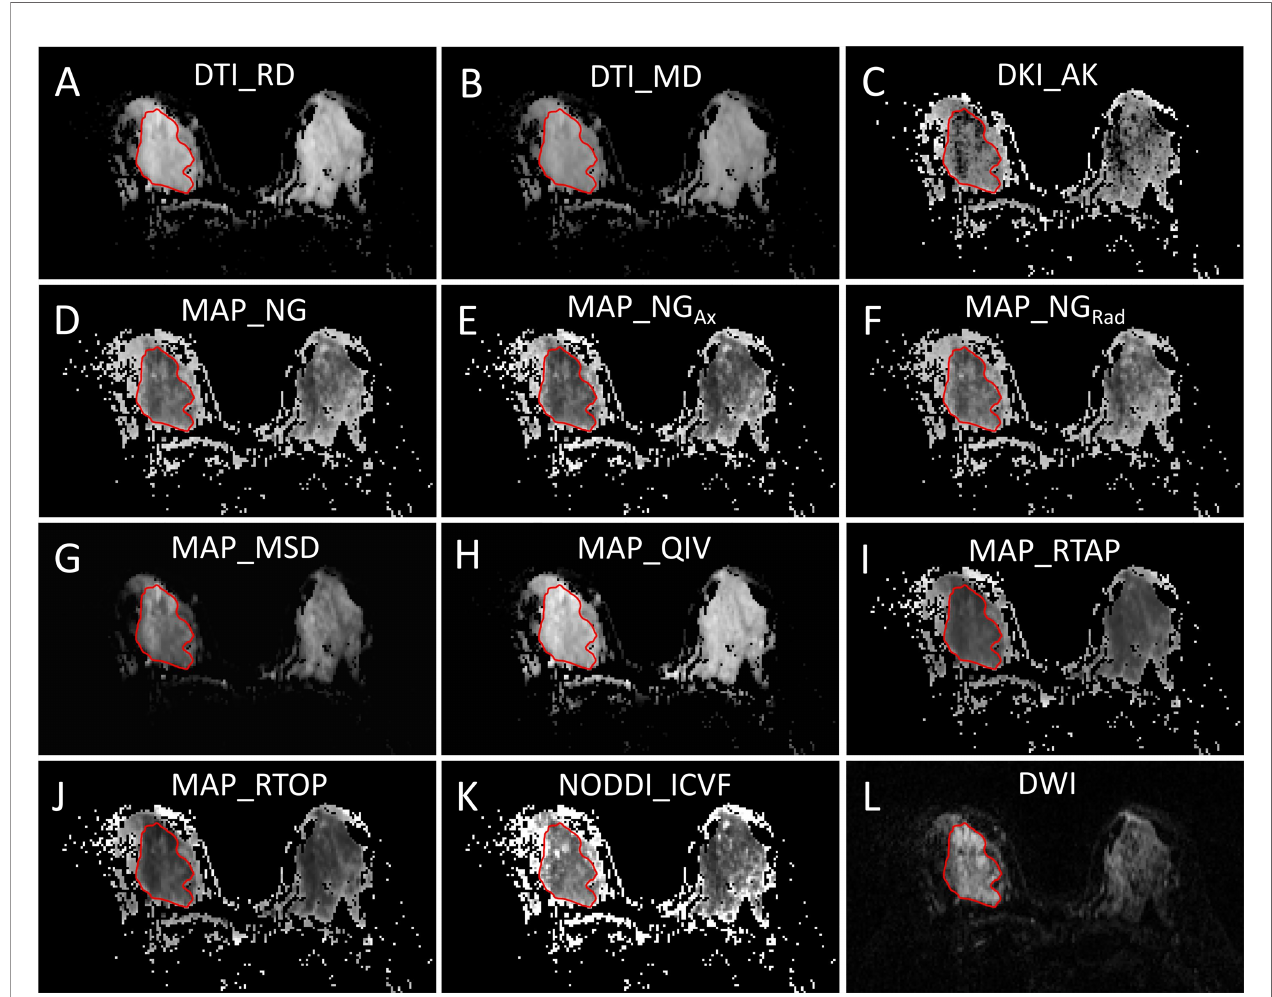
FIGURE 2 | A 44-year-old woman with pathologically con fi rmed HER2-negative breast cancer in the right breast. (A – K) Quantitative DSI parameter measurements and (L) diffusion-weighted imaging (DWI)